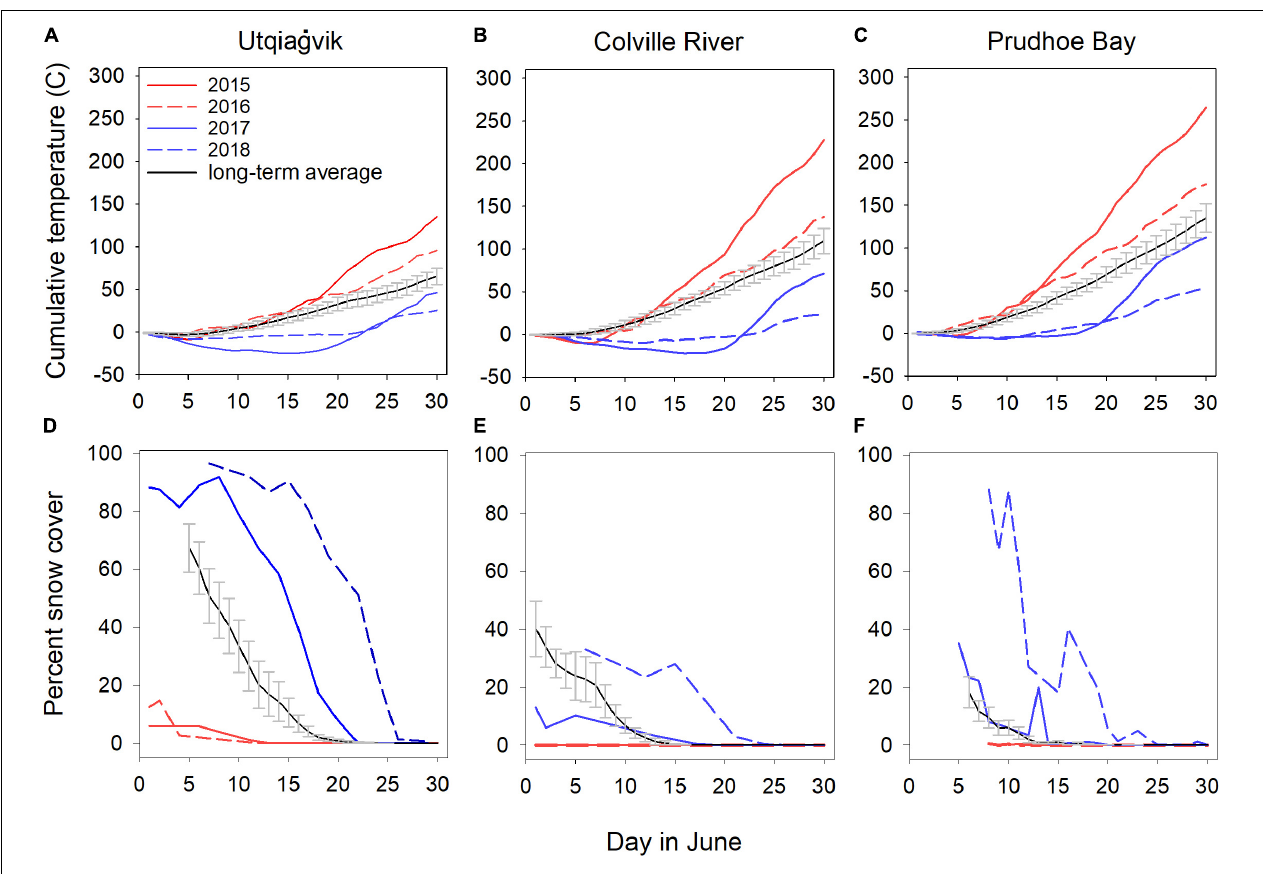
FIGURE 1 | Cumulative daily temperatures and percent snow cover in June, 2015–2018 in relation to the long-term average ± SE [i.e., Utqia˙gvik (A,D) : 2005–2014; Colville River (B,E) : 2005–2014 for temperature, 2011–2014 for snow cover; and Prudhoe Bay (C,F) : 2005–2014]. Early springs (i.e., 2015 and 2016) are illustrated in red while late springs (i.e., 2017 and 2018) are illustrated in blue.